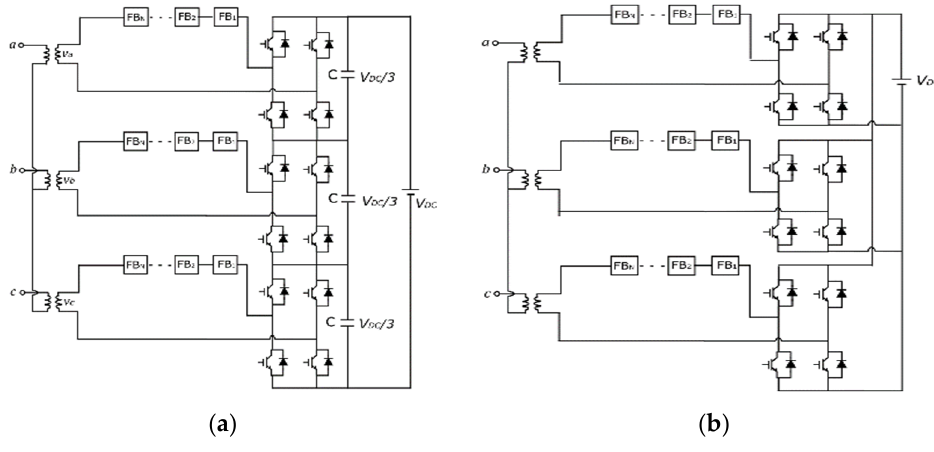
Figure 26. ( a ) Series HBHMC; ( b ) Parallel HBHMC.